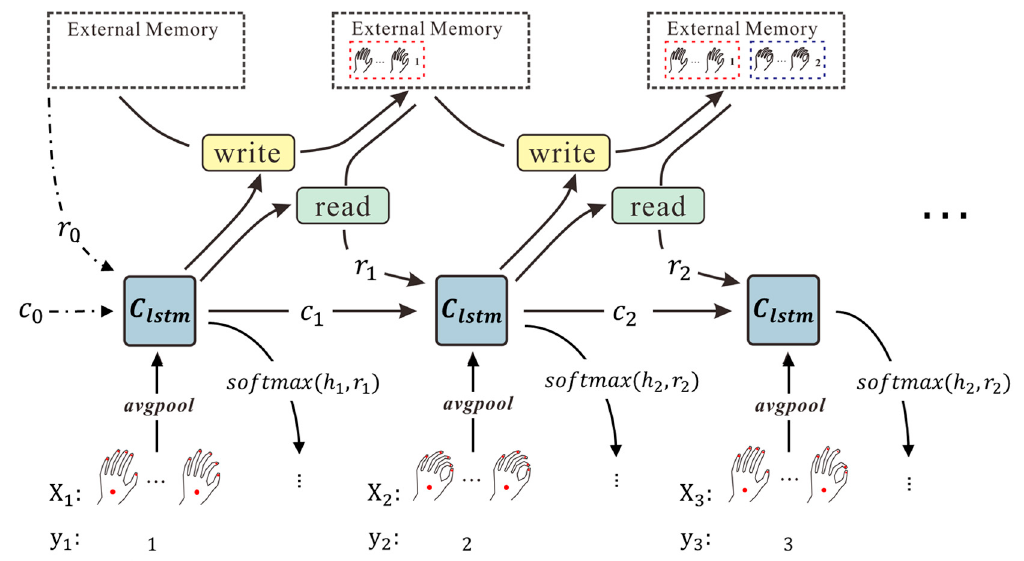
Figure 1. The structure of the GREN network. For the current time-step t , it takes the hand joint coordinate sequence X t and the corresponding sample-class y t as input and outputs the categorical distribution of prediction by a softmax layer. The controller, neuron C lstm , generates h t and c t , which are the hidden state and the cell state of the LSTM used for the next time-step. A memory, r t , is retrieved by the read heads from the external memory.